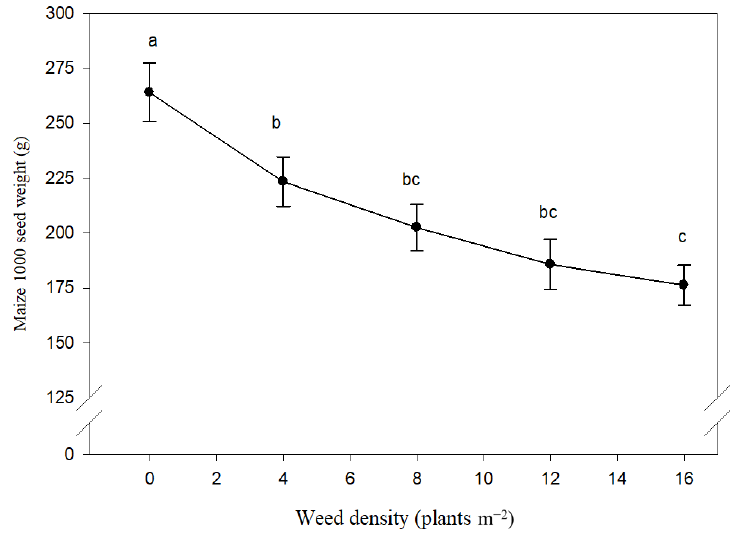
Figure 5. Effect of different density of Xanthium strumarium and Datura stramonium on maize 1000 seed weight. Mean values with the same letters are not significantly different based on Tukey’s studentized range test ( p ≤ 0.05). Vertical lines are standard error of mean ( n = 12; two years, two weed species and three replications).